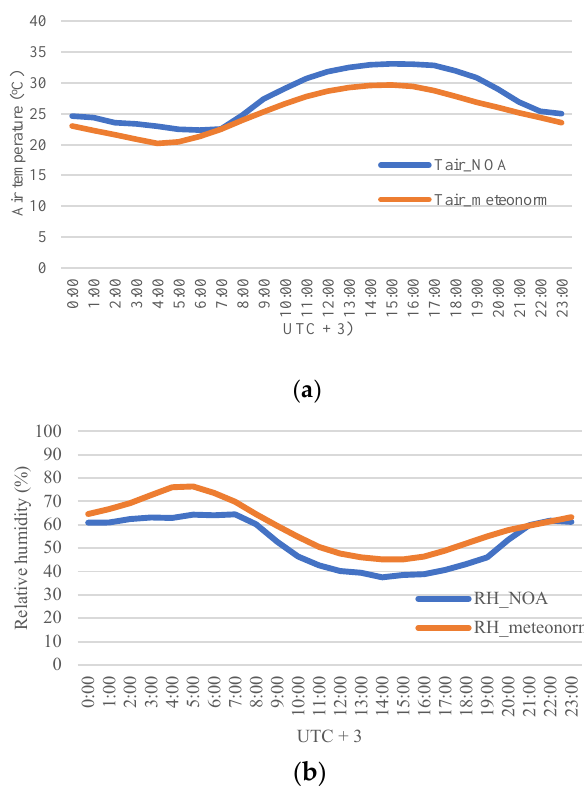
Figure 2. ( a ) Hourly average air temperature observed in 2016 compared with that observed previ- ously during summer. ( b ) Hourly average relative humidity trend observed in 2016 compared with that observed previously during summer.